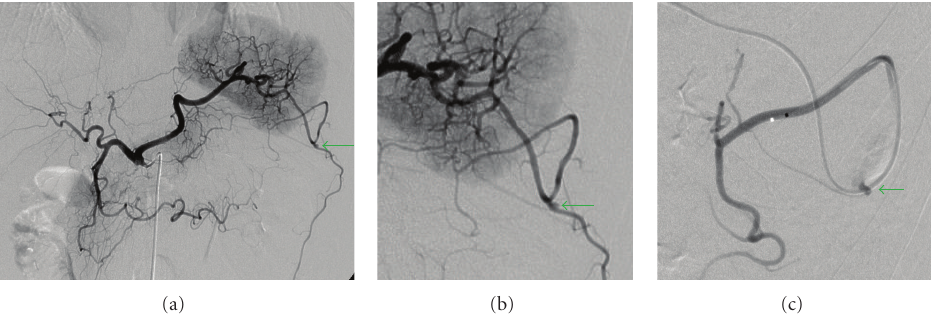
Figure 2: Celiac and left gastroepiploic arteriography revealed active extravasation (arrow) of the omental artery arising from the left gas- troepiploic artery (a, b, c).